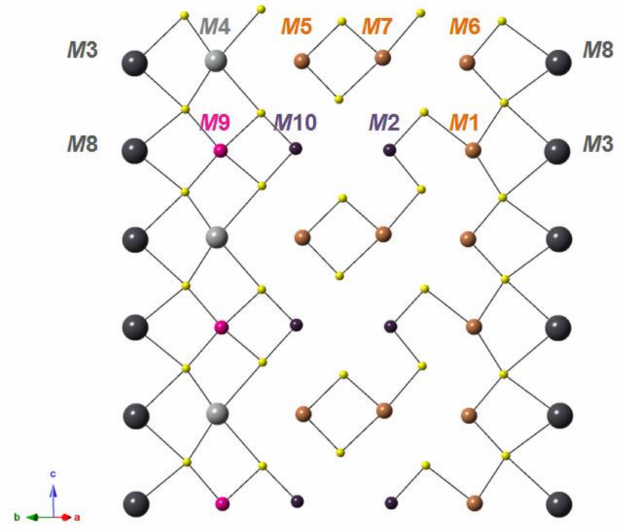
Figure 4. Organization of the (100) PbS layer in oyonite, as seen perpendicular to